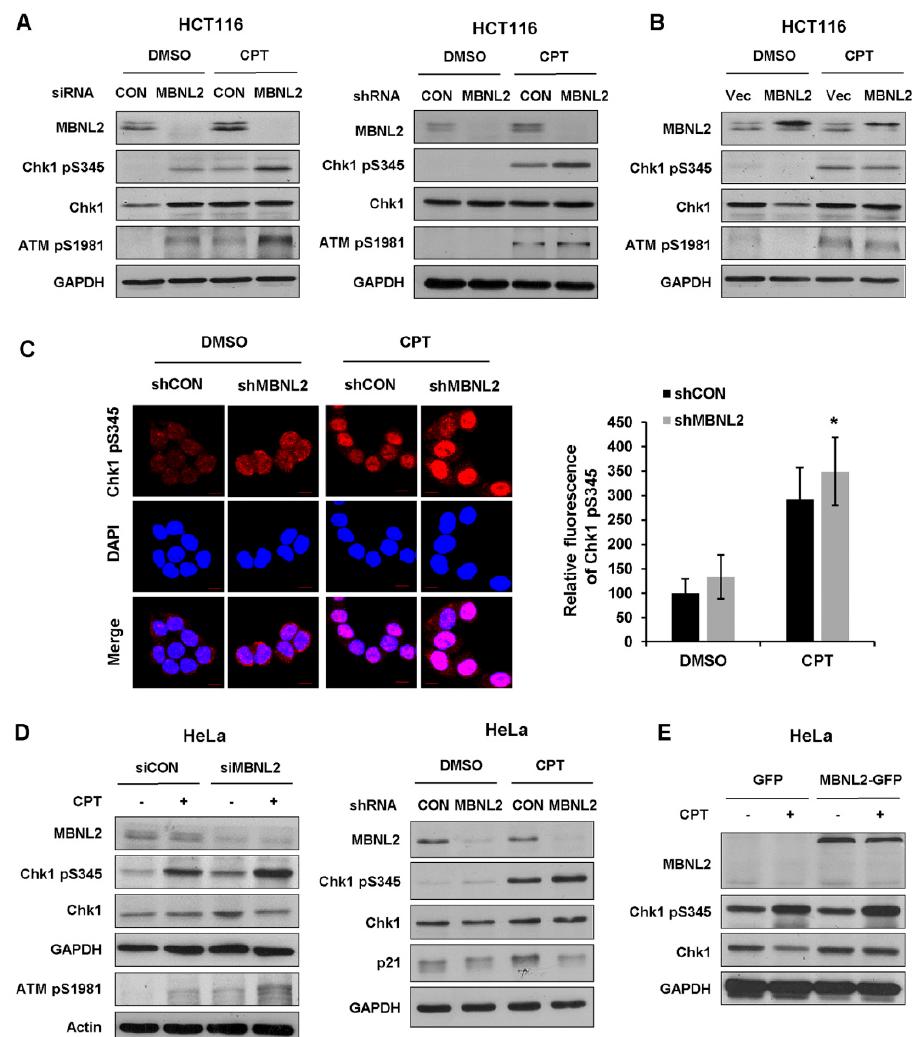
Figure 4. Depletion of MBNL2 upregulates DNA damage response. ( A ) HCT116 cells transfected with control or MBNL2 siRNA (left) and shRNA lentiviral constructs (right), ( B ) empty vector, or His-MBNL2 plasmids were treated with 1 µ M CPT for 4 h or mock-treated, then subjected to immunoblotting analysis. ( C ) Representative images (left) of Chk1 pS345 immunostaining in the HCT116 cells transfected with control or MBNL2 shRNA lentiviral constructs and treated with 1 µ M CPT for 4 h or mock-treated. Relative fluorescence intensity was quantified (right). ( D ) Immunoblotting of Chk1 pS345 in the HeLa cells transfected with control or MBNL2 siRNA (left) and shRNA lentiviral constructs (right), ( E ) empty vector, or MBNL2-GFP plasmids and treated with 1 µ M CPT for 4 h or mock-treated. * p < 0.05.